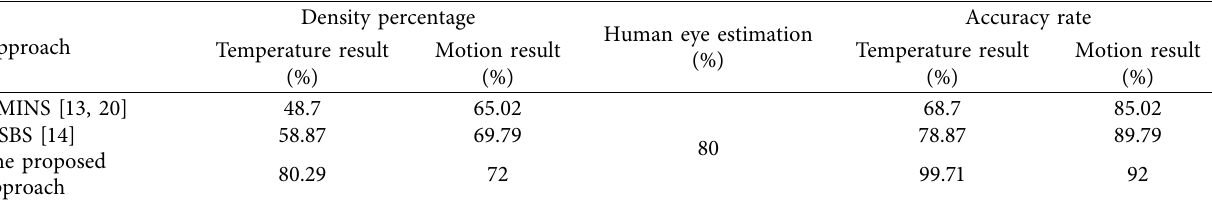
Figure 21: Density calculation using a thermal image utilizing heat signature and background subtraction by proposed approaches. Table 1: Accuracy comparisons of diferent